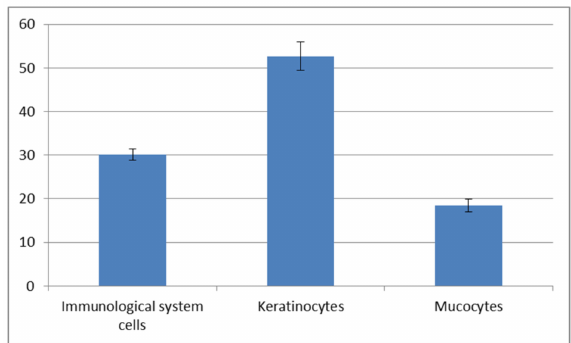
Figure 7. Cellular composition of mucus collected in the autumn-winter period.